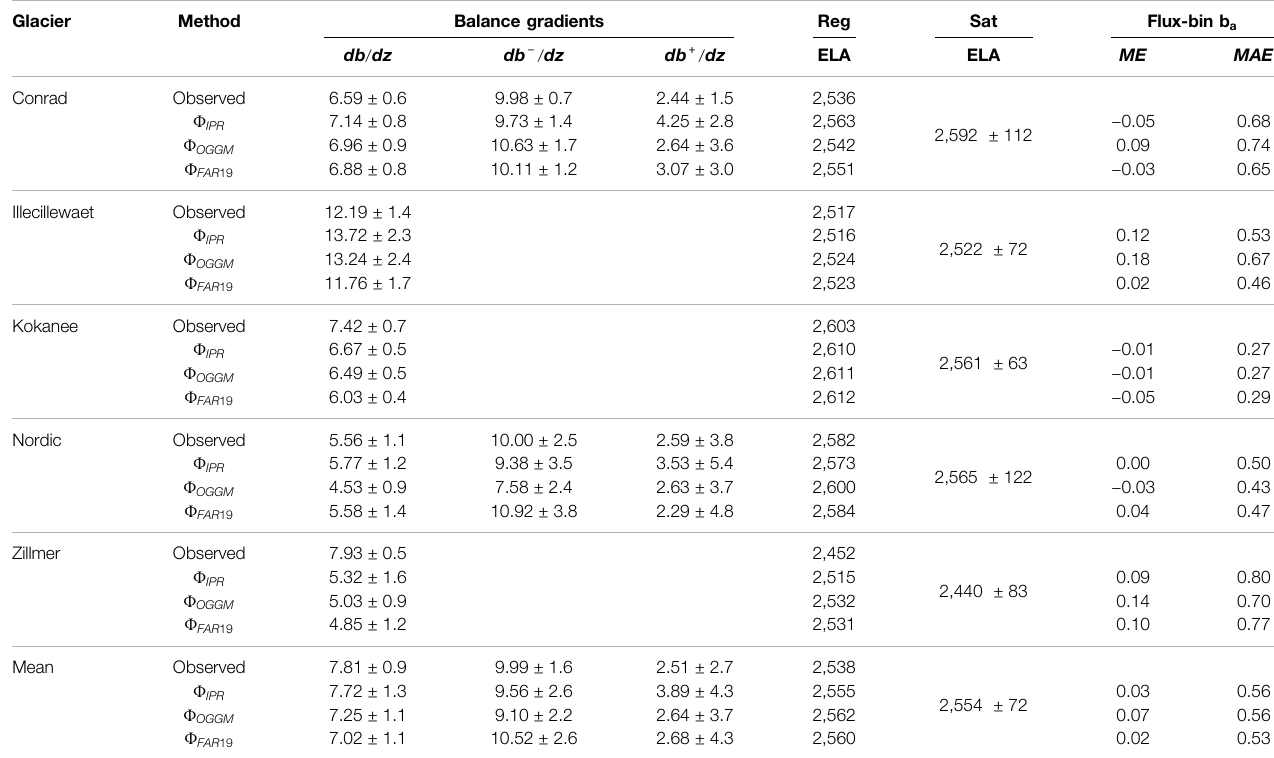
TABLE3| Averagemass-balancegradients(mmw.e.m − 1 ),regression-estimatedELA(Reg),satellite-estimatedELA(Sat),and fl ux-bin b a ME (mw.e.),and MAE (mw.e.)for each glacier and for all glaciers collectively. Supplementary Tables 2 – 6 contain annual statistics for each glacier. Glacier